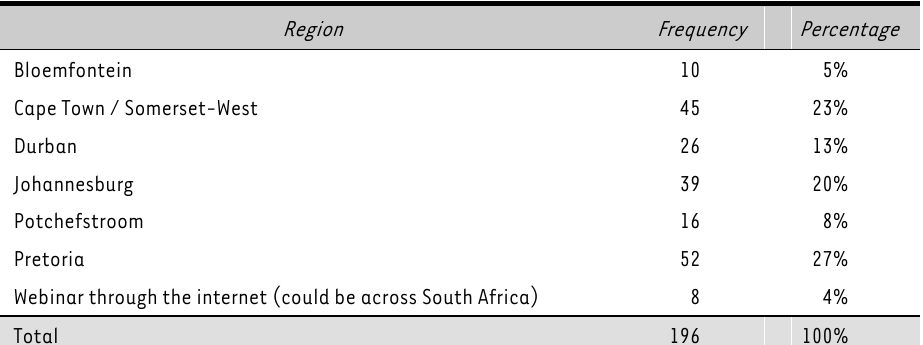
TABLE 1: Demographic information of the respondents Region Frequency